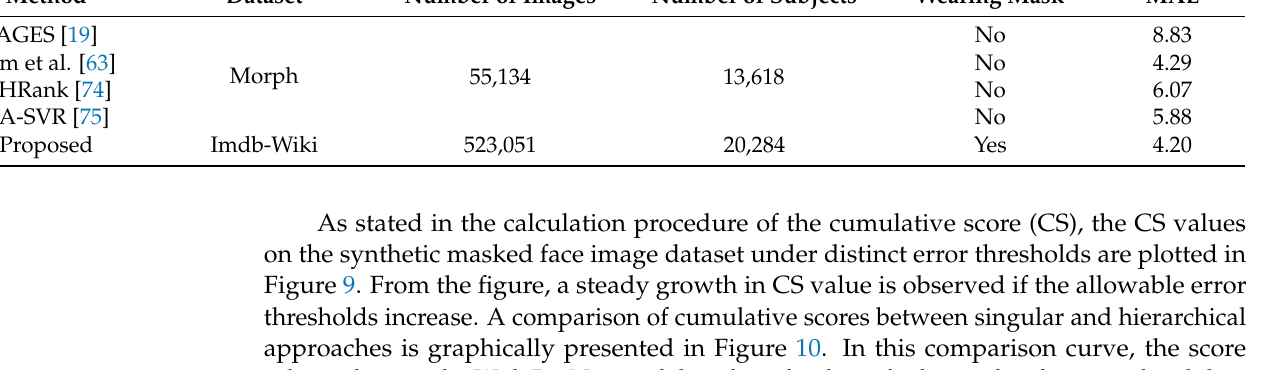
Table 5. Performance comparison with existing prominent facial age estimation methods.